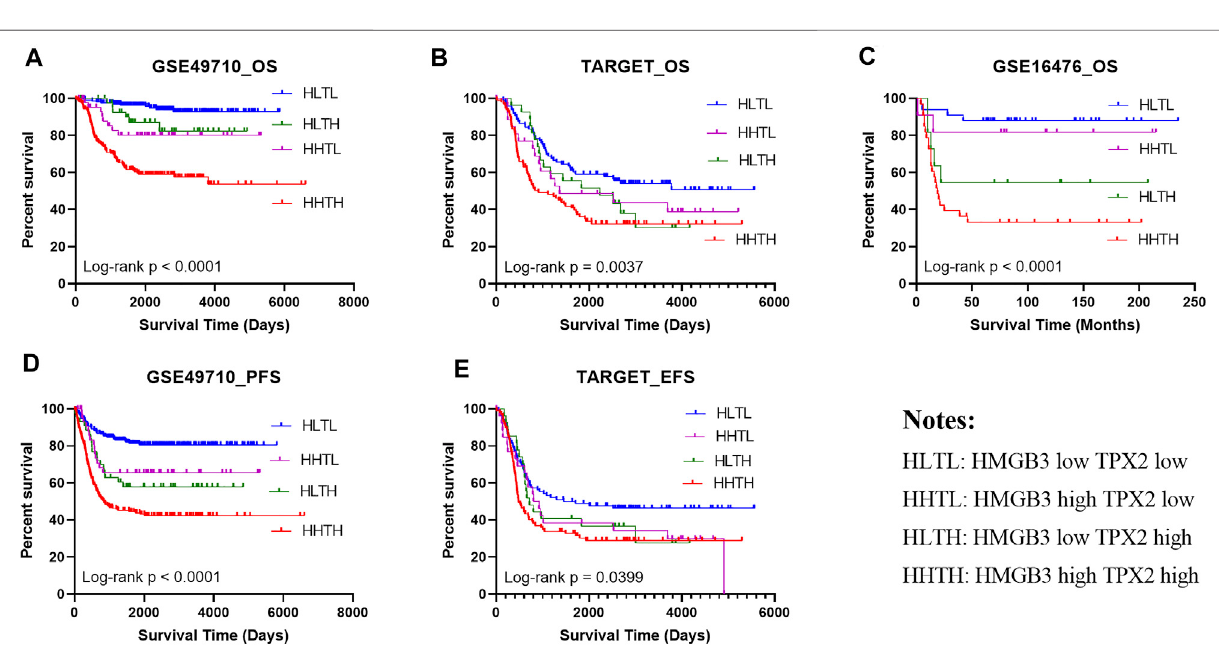
Frontiers in Cell and Developmental Biology |